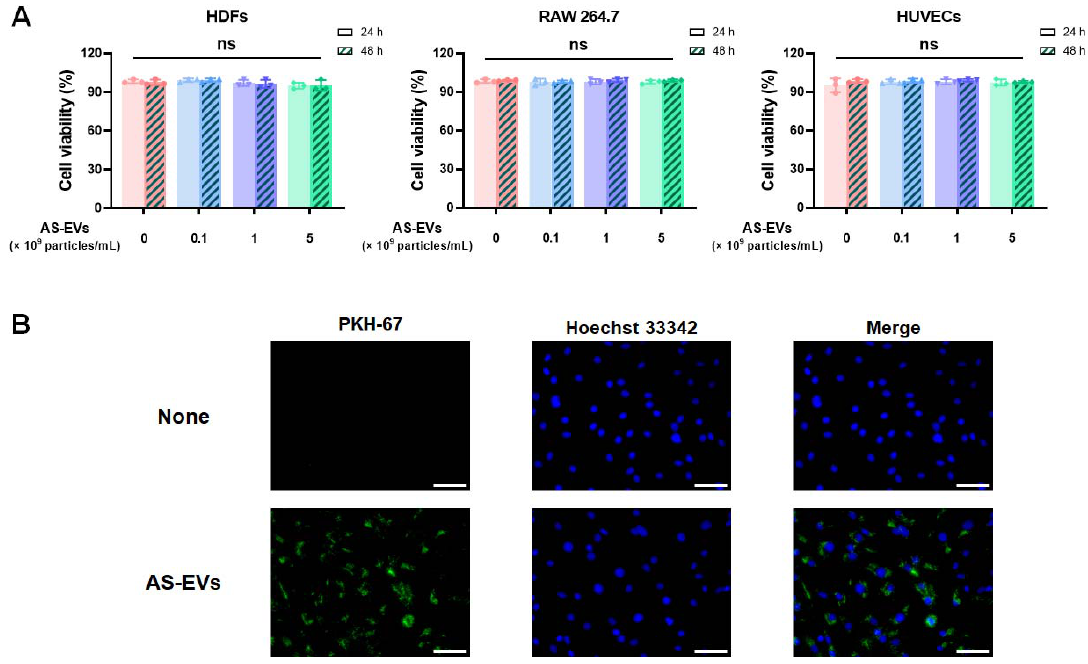
Figure 2. Cytotoxicity and intracellular delivery of AS ‐ EVs. ( A ) Cytotoxicity of AS ‐ EVs in HDFs, RAW 264.7 cells, and HUVECs, respectively. After 24 h and 48 h treatment with AS ‐ EVs, viability was measured by trypan blue exclusion assay. (ns: not significant, n = 3) ( B ) Uptake of AS ‐ EVs into HDFs. HDFs were incubated for 8 h in a growth medium containing PKH ‐ 67 green fluorescent dye ‐ labeled AS ‐ EVs, and then observed under a fluorescence microscope. Scale bar indicates 100 μ m.